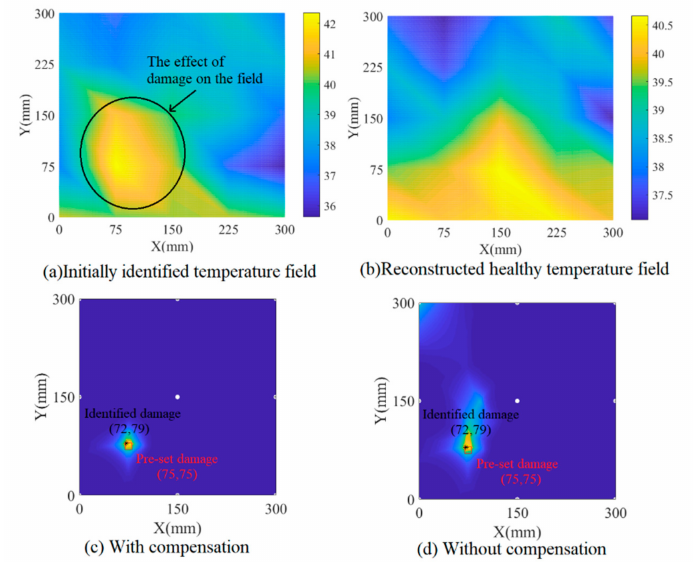
Figure 15. Experimental results of damage